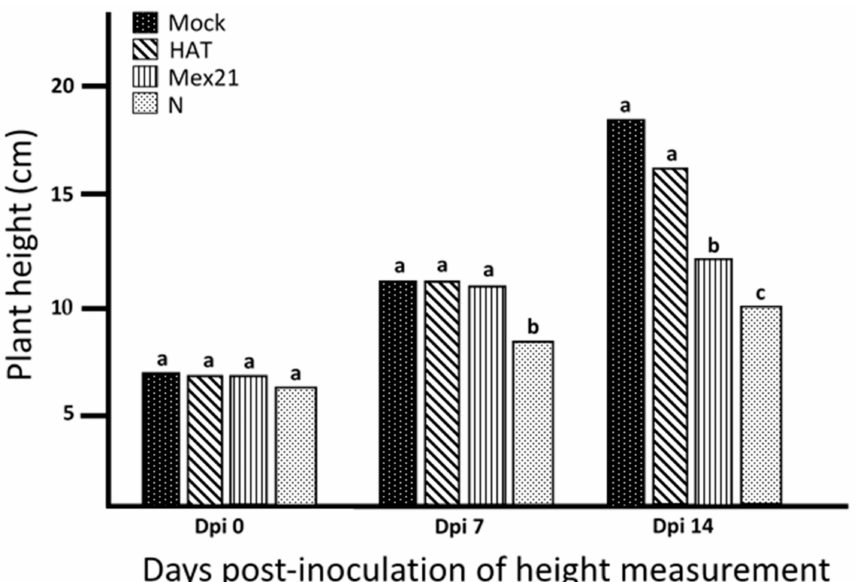
Figure 1. Height of plants infected with each of three Tobacco etch virus (TEV) strains. Mean value of height (cm) measured from soil-line to apical bud on the main stem of plants infected with TEV strain HAT, Mex21 or N along with buffer-mock control (Mock), measured at 0 (day of inoculation), 7 and 14 days post-inoculation (dpi). Statistical comparisons were made within a sample date; treatments followed by the same letter are not significantly different (Glimmix by Tukey–Kramer with p = 0.05).